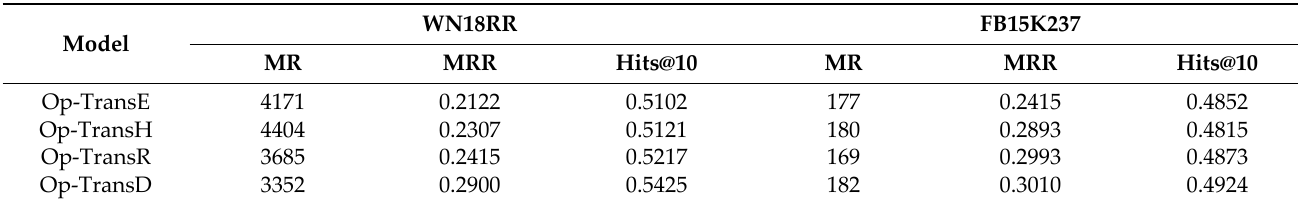
Table 6. Results of the performance of the Op‑Trans framework on the baseline model on two datasets, WN18RR and